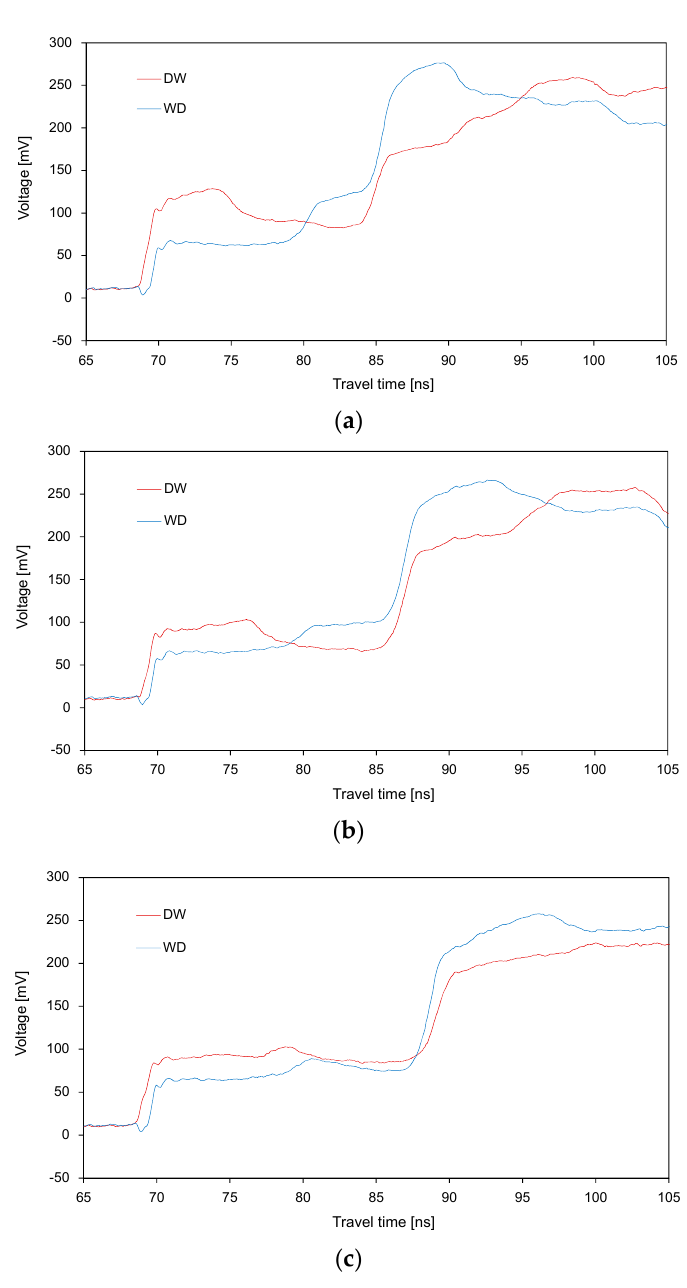
Figure 9. Comparison between the signals obtained from the two-segmented containers at average SWCs of: ( a ) 0.105; ( b ) 0.14; ( c ) 0.175.